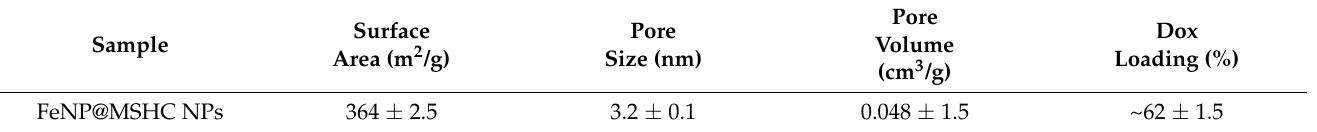
Figure 2. ( a ) N 2 adsorption-desorption; ( b ) pore size distributions; ( c ) zeta potential measurement; and ( d ) particle size distributions of the FeNP@MSHC NPs. Table 1. Mesopore properties of FeNP@MSHC